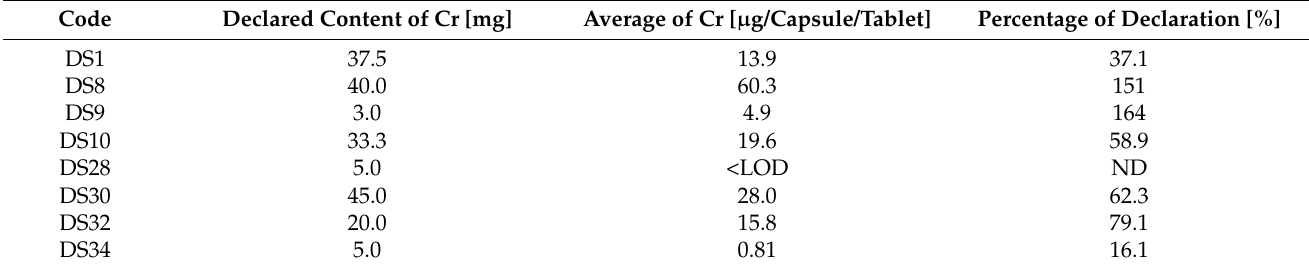
Table 8. Evaluation of the manufacturer’s declaration for Cr